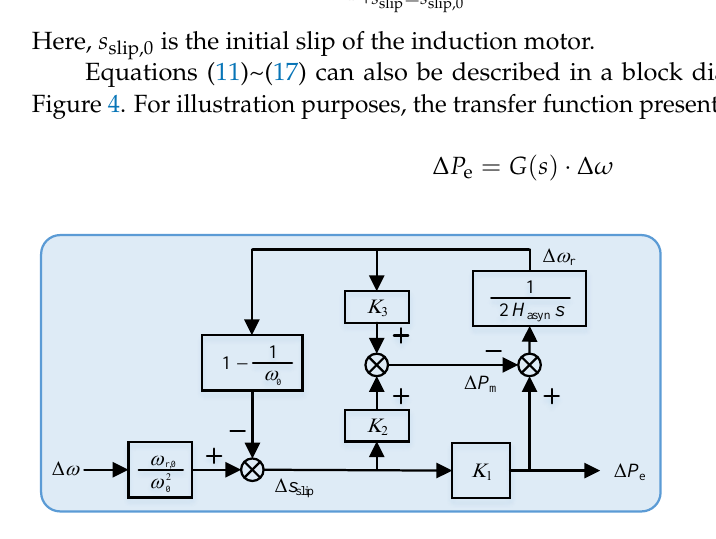
Figure 4. Block diagram of the induction motor’s small-signal